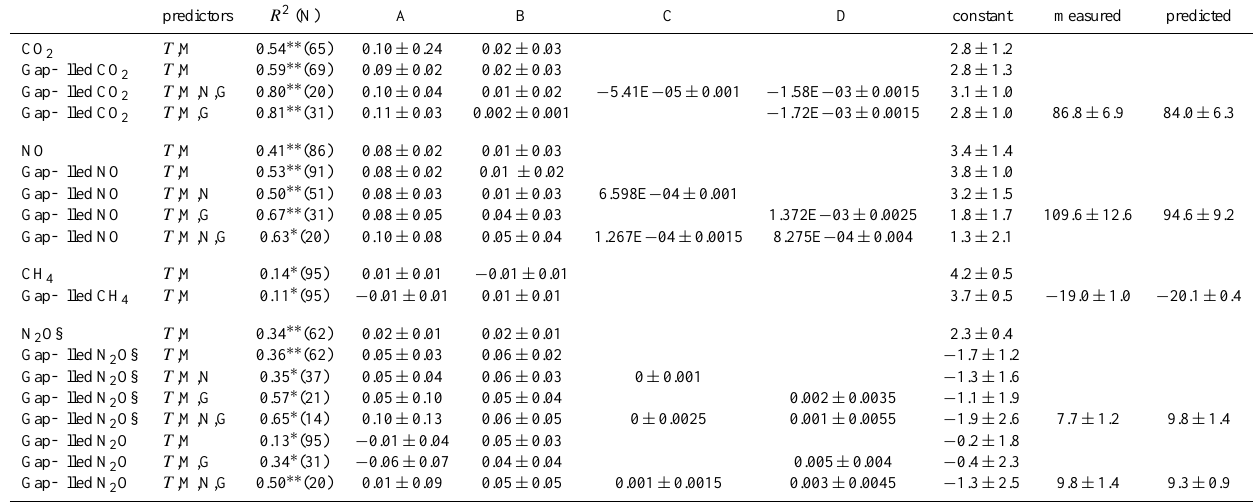
Table 6. Results from linear regression analysis (Flux = A*soil temp+B ∗ soil moisture+C*Ndeposition+D ∗ gross